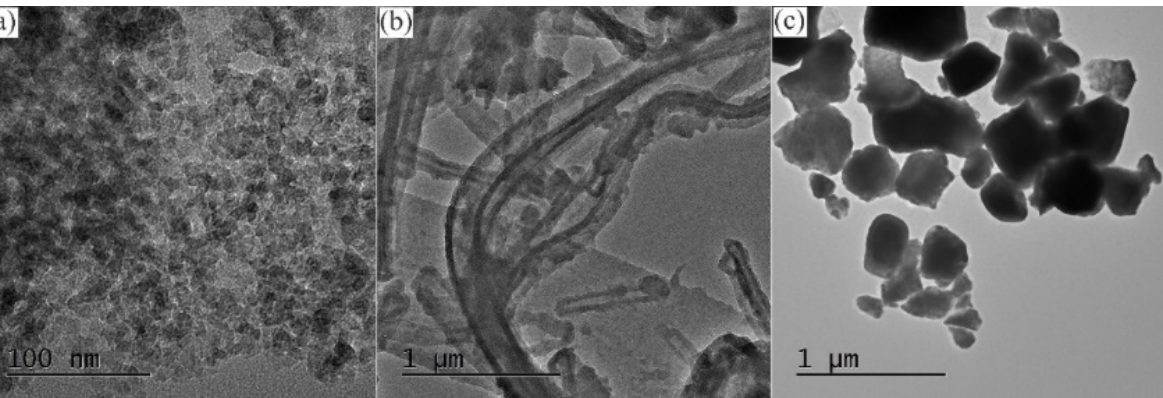
Figure 3. TEM image of the reinforcement particles. ( a ) Al 2 O 3 nanoparticles, ( b ) MWCNTs, and ( c ) Ta 2 C particles.